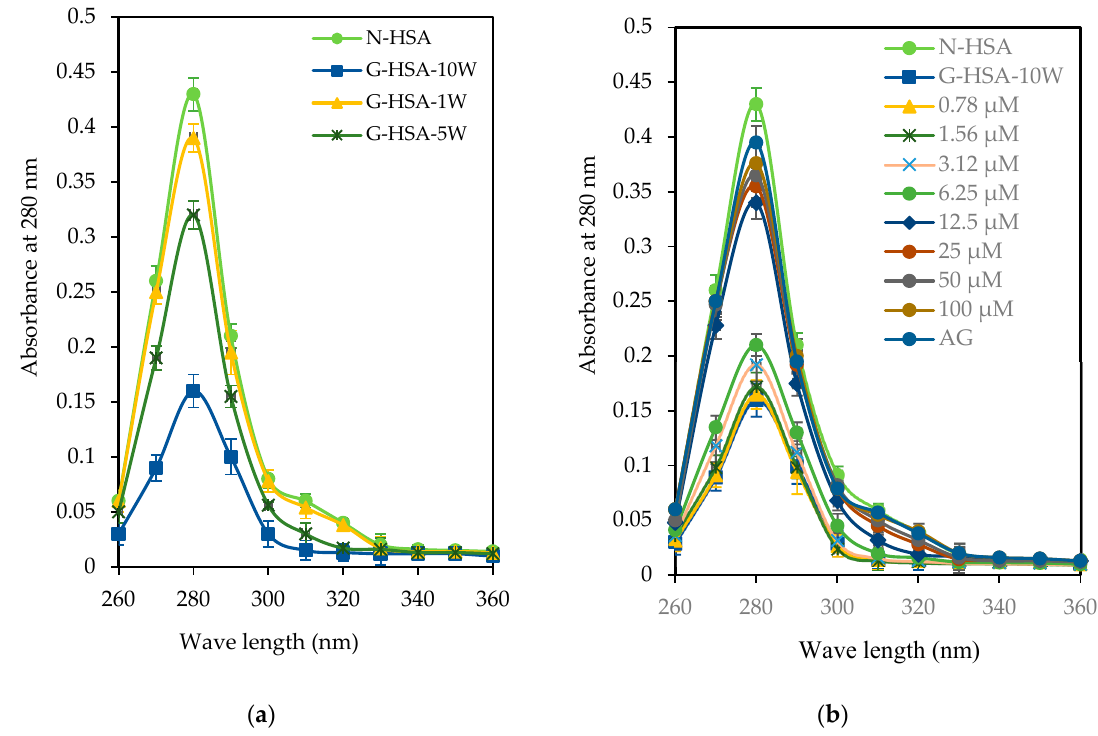
Figure 6. UV-spectra were analyzed for N-HSA, G-HSA-1W, G-HSA-5W, and G-HSA-10W ( a ). Effect of garlic extract on the overall protein structure changes during glycation of HSA (10 weeks) with different concentrations (0.78–100 µg/mL) ( b ). All the sample readings were recorded in the range of 260–360 nm. Data is presented as mean ± SD values. t test was adopted for the comparison between N-HSA vs. G-HSA-1W, G-HSA-5W, and G-HSA-10W.